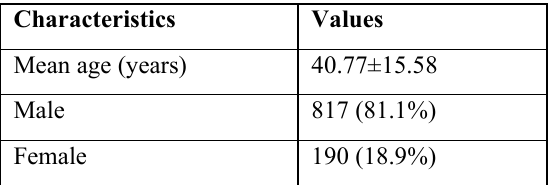
Table-1: Mean age and gender frequency of